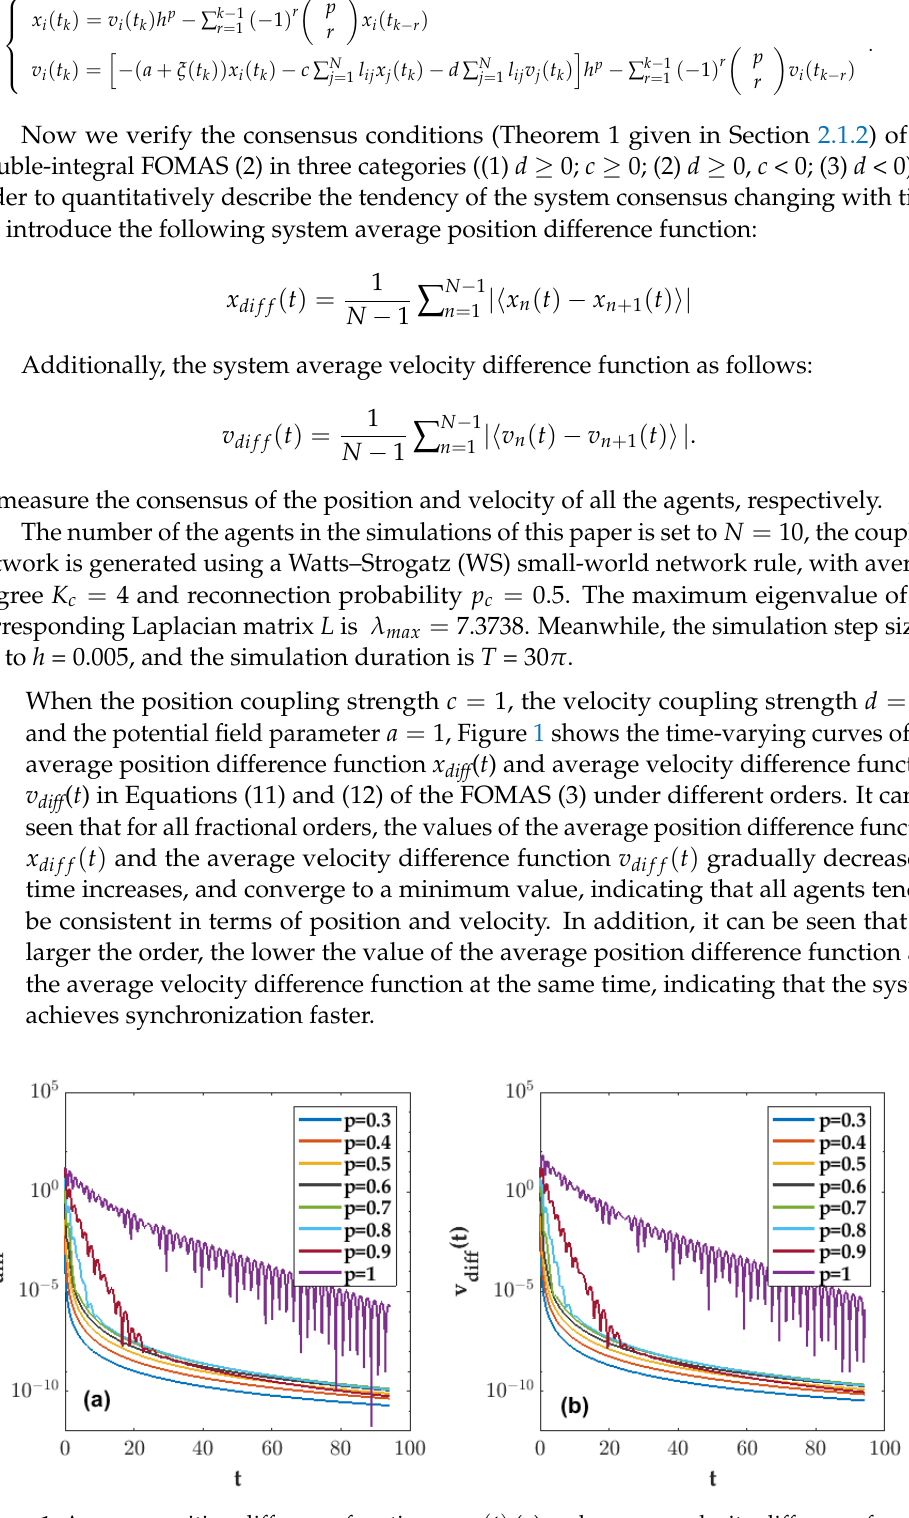
Figure 1. Average position difference function 𝑥 𝑑𝑖𝑓𝑓 (𝑡) ( a ) and average velocity difference function 𝑣 (𝑡) ( b ) curves of time of the FOMAS (3) with different orders p (the case 𝑑 ≥ 0, 𝑐 ≥ 0 ).